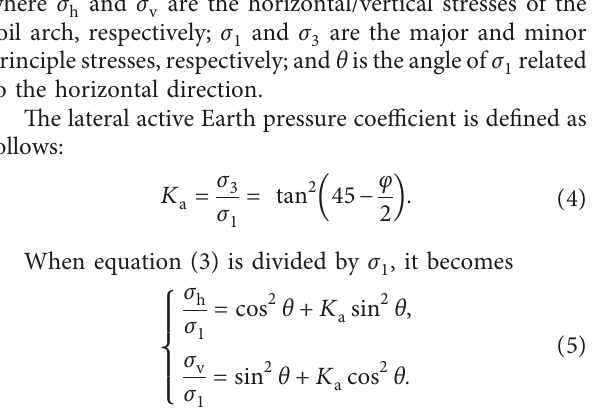
Figure 2: Schematic diagram of stress state analysis of the deflected soil strip element.